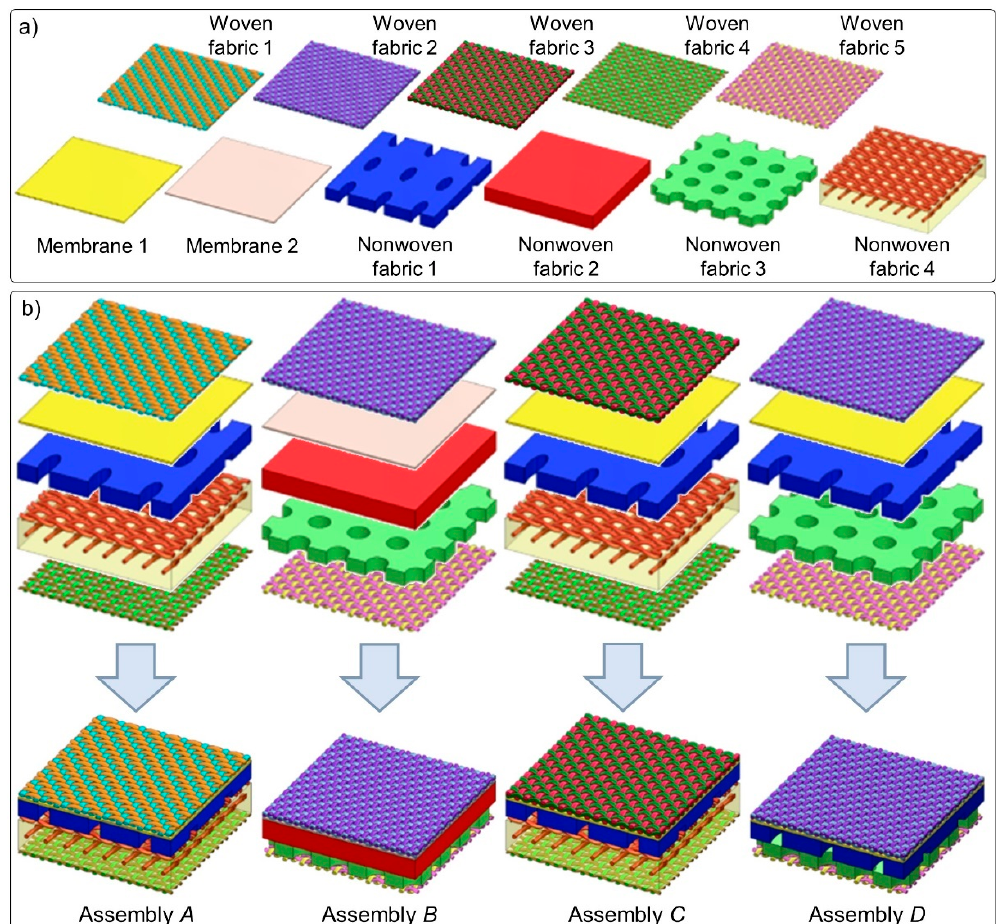
Figure 5. ( a ) 3D models of all eleven textiles included in the four tested assemblies; ( b ) 3D models of four tested assemblies (dimensions: 10 mm × 10 mm).